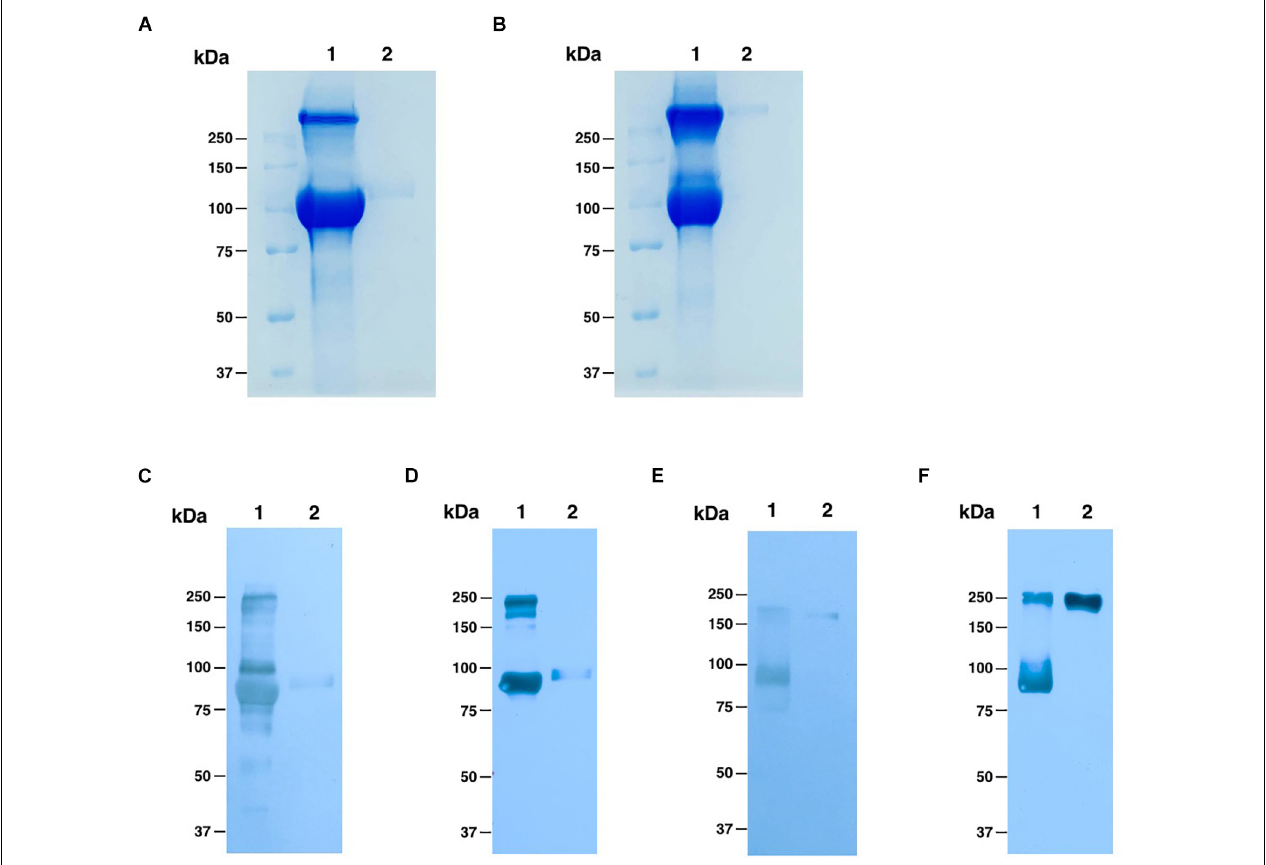
FIGURE 3 | Analysis of purified plant-produced ACE2-Fc (lane 1) and commercial HEK293-produced ACE2-Fc (lane 2). Coomassie-stained SDS-PAGE under reducing (A) and non-reducing conditions (B) . Western blotting analysis under reducing condition with detection using a rabbit anti-ACE2 antibody (C) and an anti-human gamma-HRP conjugated antibody (D) . Western blotting analysis under non-reducing condition probed with a rabbit anti-ACE2 antibody (E) and an anti-human gamma-HRP conjugated antibody (F) .